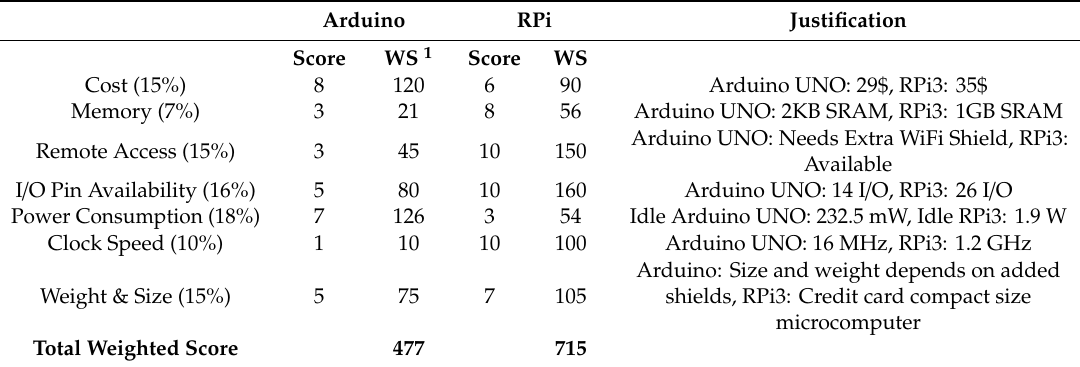
Table 1. Edge devices alternative